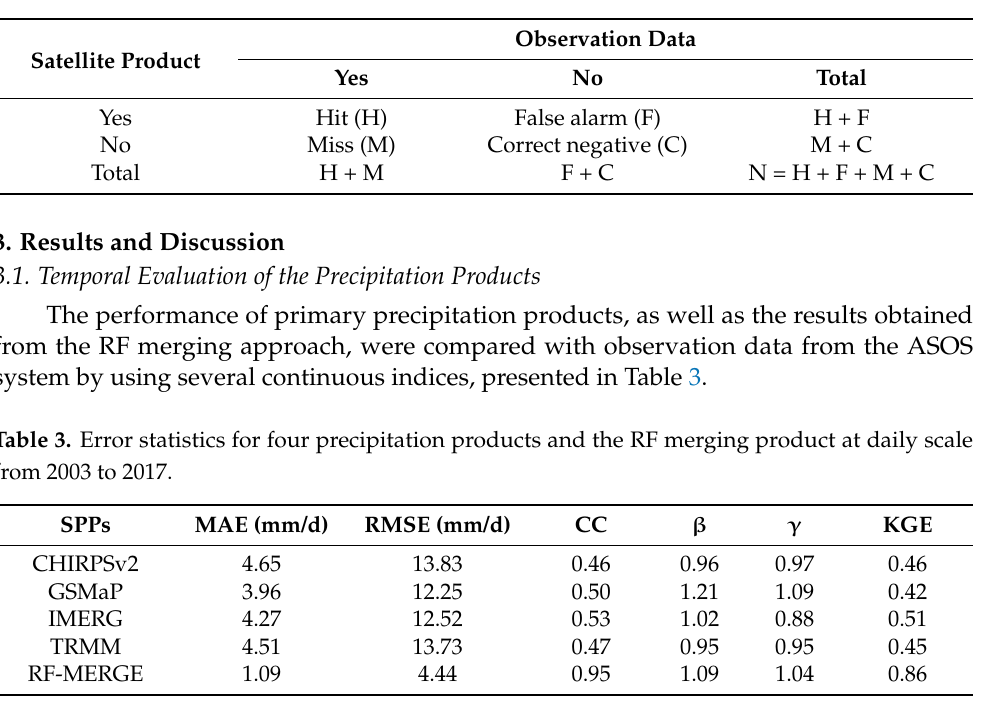
Table 2. The contingency table was used to identify the categorical performance.